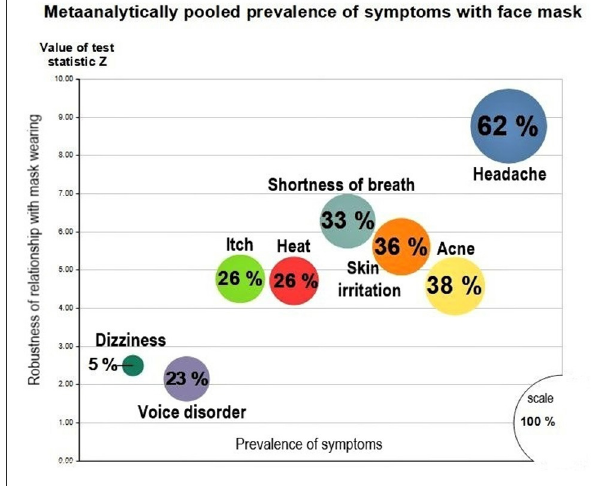
FIGURE13 Representation of symptom prevalence in % during face mask use as the area of the circles. Along the X-axis, the main recorded symptoms are listed. The higher the prevalence, the bigger the circles and the more often the symptoms. The Y-axis gives the probability of non-random occurrence of the symptoms and includes the statistical Z-value. Thus, the higher the circles are arranged, the more robust is the relationship to face mask wearing. The meta-analytical statistical data were as follows: Headache: 62% (95% CI 48–75%), Z 8.77, p < 0.00001; Acne: 38% (95% CI = 22–54%),